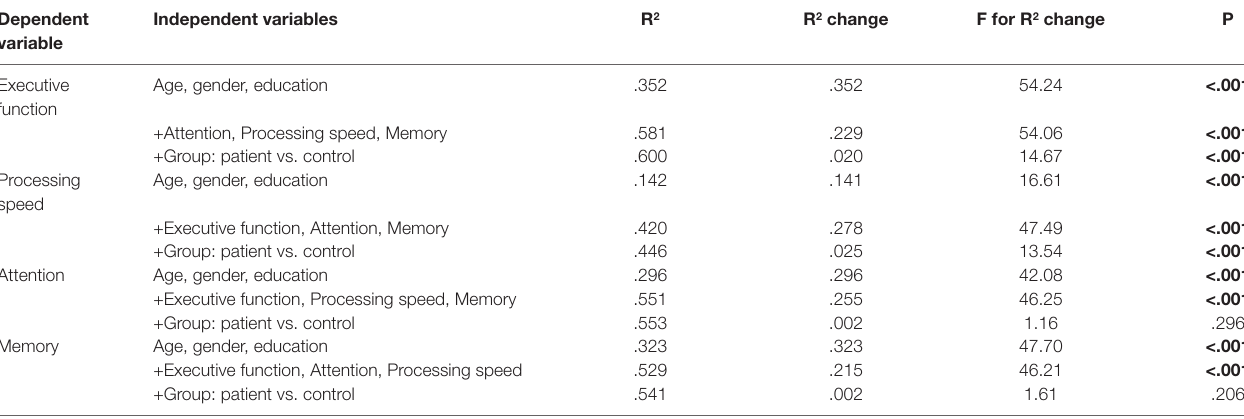
Bold values indicate statistical significance.